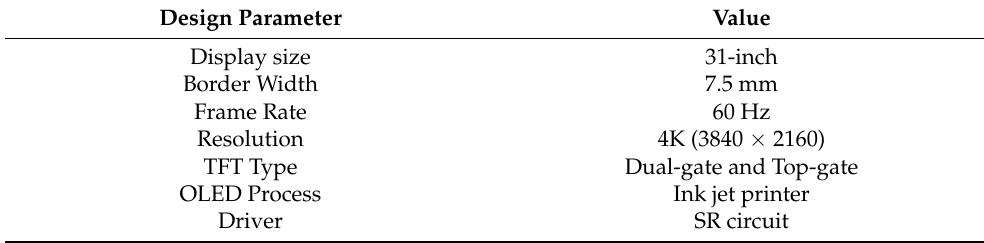
Figure 10. ( a ) Structure of AMOLED display; ( b ) Image of 31-inch 4K AMOLED display. Table 2. Details of the proposed 31-inch AMOLED display.